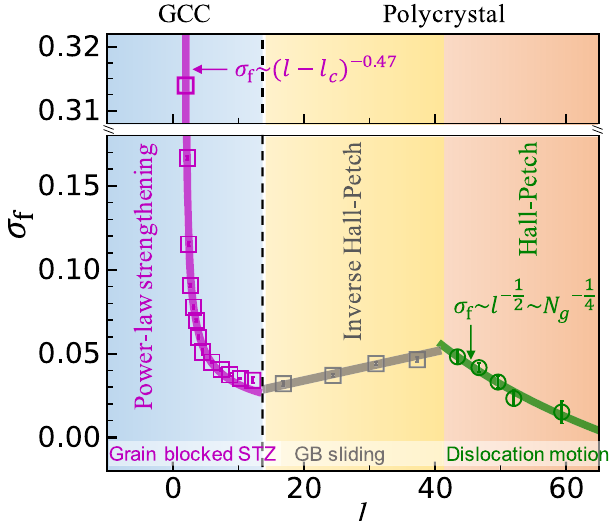
Fig. 1 Three regimes of fl ow stress σ f ( l ). As grain diameter l decreases, σ f exhibits the Hall – Petch relationship (green curve) and the inverse Hall – Petch softening (grey line) in polycrystal regime 1 – 6,10 , and a power-law strengthening (magenta curve) in the glass-crystal composite (GCC) regime. Symbols refer to the measured results at mixing ratio x = 0.5. The fi tted l c = 1.89 ± 0.01. The boundary (dashed line) between the inverse Hall – Petch softening and power-law strengthening coincides with the polycrystal – glass transition (see Supplementary Note 1 for the details). The mechanisms of the three regimes: dislocation motion, grain boundary (GB) sliding, and grain blocked shear transformation zone (STZ) are shown in the